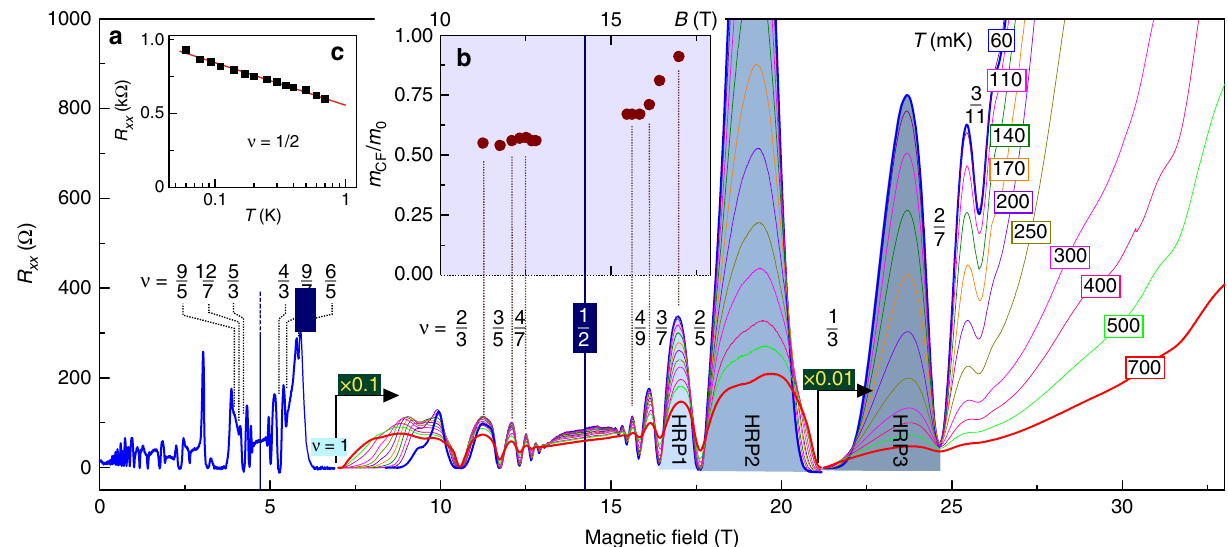
Fig. 2 Temperature-dependent magnetotransport up to 33 T. a R xx at T = 60 mK (blue trace). The other colors show R xx ( B ) in the fractional quantum Hall regime for higher temperatures. The high resistivity phases HRP1, HRP2, and HRP3 are indicated by the shaded region. b Mass of composite fermions extracted from the temperature dependence of the R xx oscillation amplitude. c Temperature dependence of R xx at ν = 1/2. The decreasing resistance with increasing temperatures indicates a residual interaction between composite